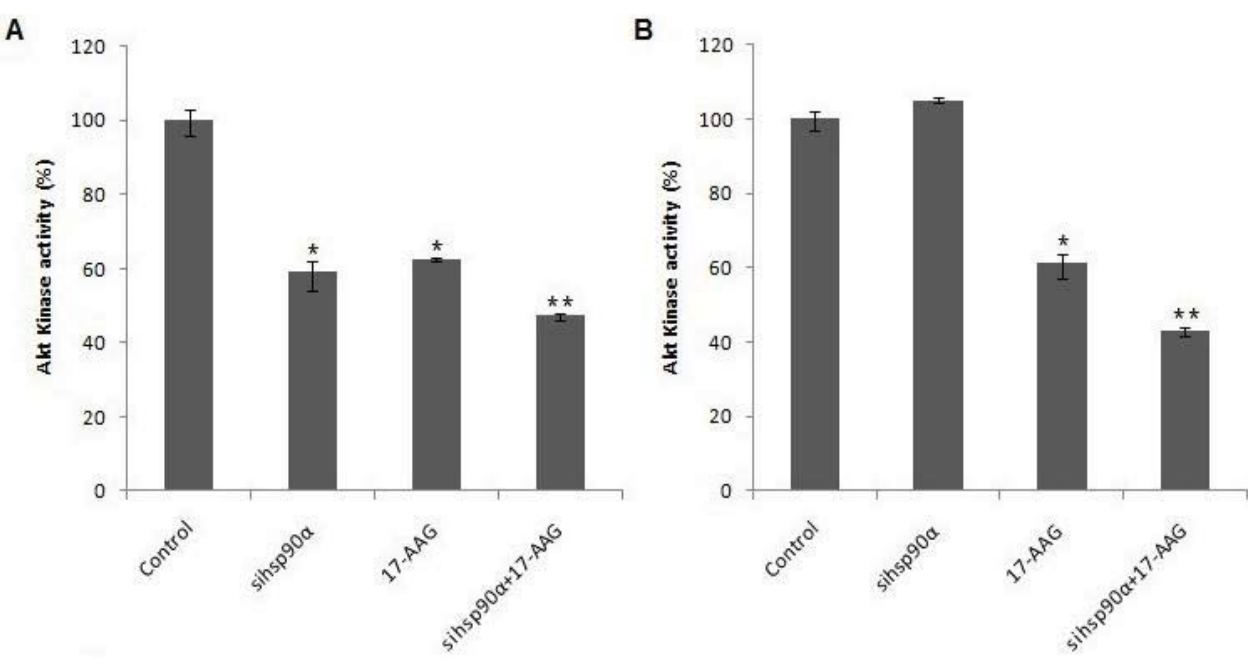
Figure 5. Hsp90 (cid:2) inhibition results in loss of Akt activity in U87-MG cell line. The Akt activity (%) was deduced as the fraction of the observed Akt activity in treated samples relative to the total Akt activity in the untreated sample after 48 h ( A ) and 72 h ( B ). sihsp90 (cid:2) represent cells treated with hsp90 (cid:2) specific siRNA. sihsp90 (cid:2) + 17-AAG represent concurrent assays where the cells were treated with sihsp90 (cid:2) and 17-AAG for either 48 h or 72 h. * p ≤ 0.05 and ** p ≤ 0.001 were considered statistically significant (Data values are mean ± SD, n = 3).